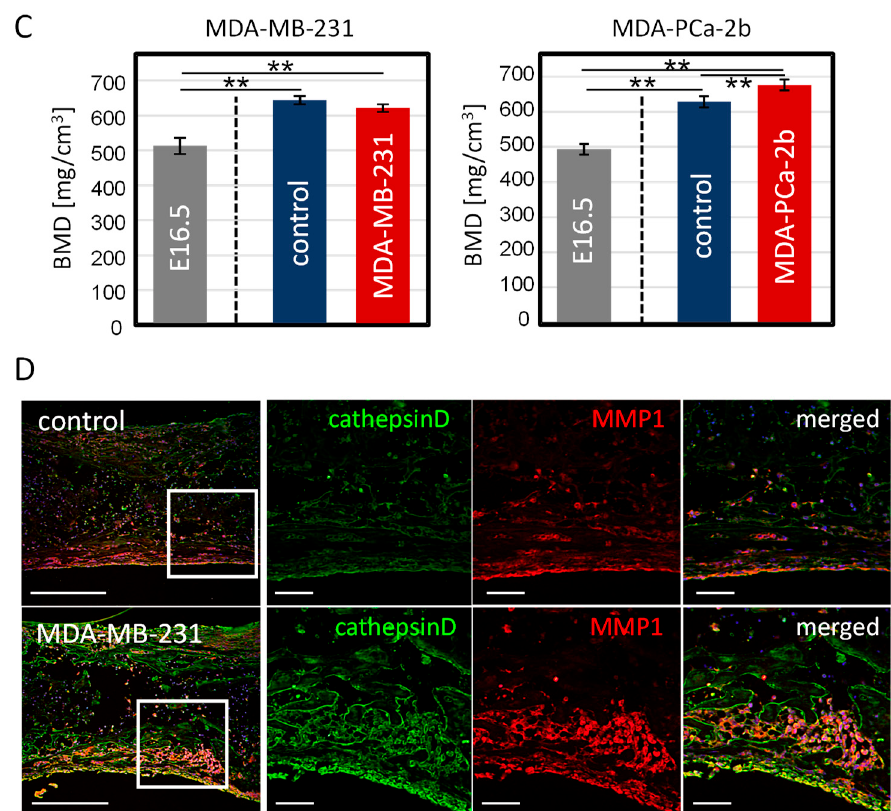
Figure 1. ( A ) Schematic illustration of an ex vivo bone metastasis culture model. E16.5 mouse femurs were cultured inside the static longitudinal loading device with circulating cancer cells. ( B ) Micro-CT images of the femurs before cultivation (E16.5) and after cultivation with or without tumor cells. Scale bars: 0.5 mm. ( C ) Bone mineral density (BMD) analysis of the femurs before cultivation (E16.5) and after cultivation (separated by dot lines) with or without tumor cells. ( D ) Immunohistochemical analysis of the cultured femurs with and without breast cancer MDA-MB-231 cells. Magnified images of the enclosed regions are shown on the right side. Green; cathepsin D, Red; MMP1. Scale bars: 100 µm. ** p < 0.01.